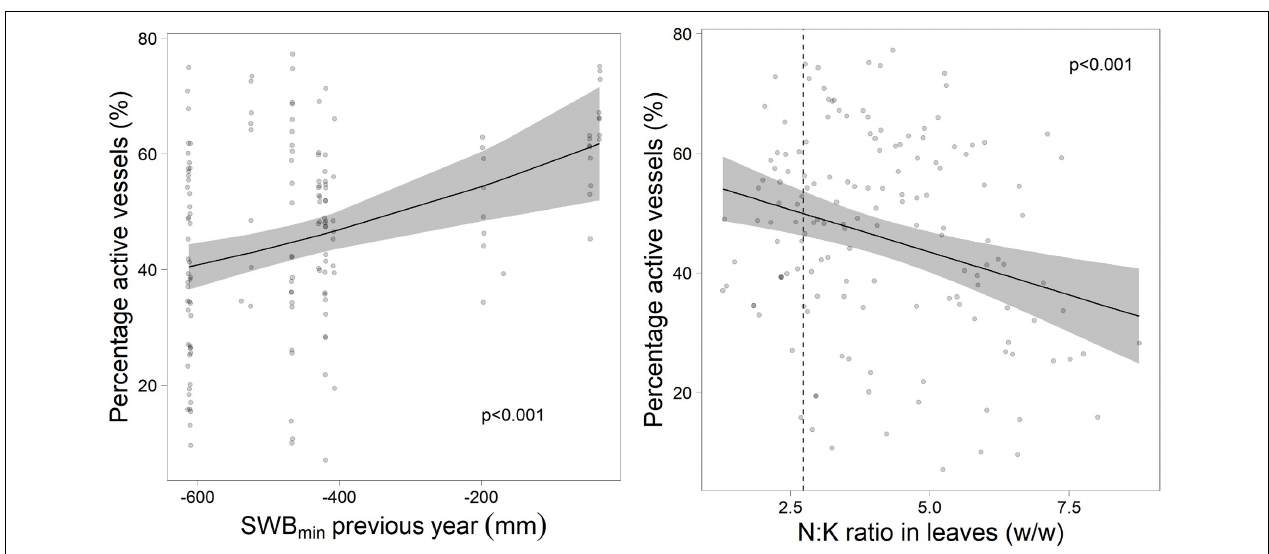
FIGURE 10 | Proportion of active vessels in relation to the drought in the previous year (left) and the foliar ratio of N:K (right) . The dotted line gives the upper threshold for harmonic N:K ratio according to Göttlein (2016).